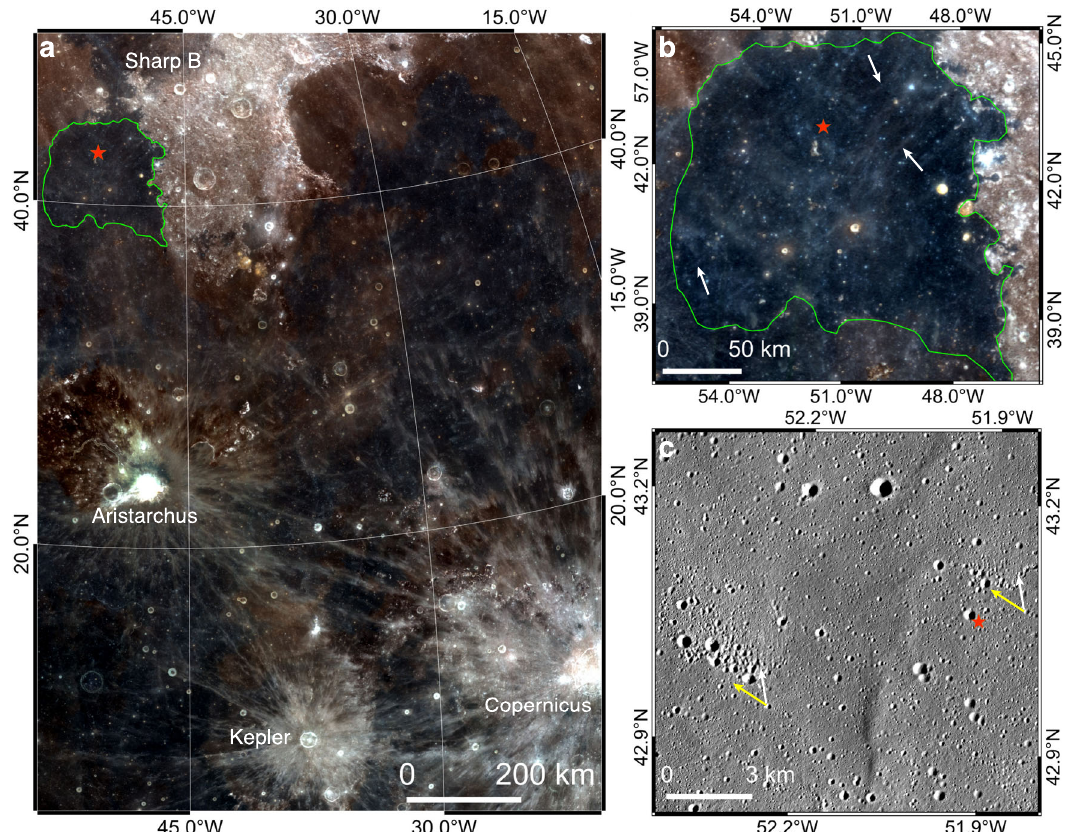
Fig. 9 | Non-radial extension of chains of secondaries near the Chang ’ E-5 sam- pling site (red star). a Regional context of the Chang ’ E-5 sampling site. b Faint impact rays (white arrows) are widespread in the sampling region. c Chains and clusters of secondaries near the sampling site. Their lateral orientations (yellow arrows) are not radial to the Aristarchus crater 49 , but the morphology of the